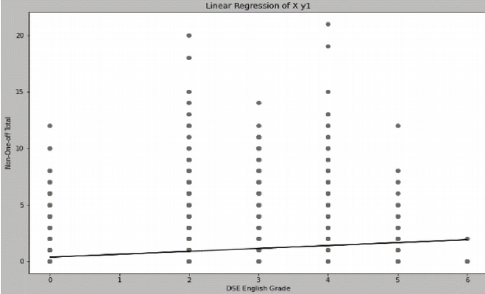
Figure 17. Linear Regression of X y1 in Finding 3